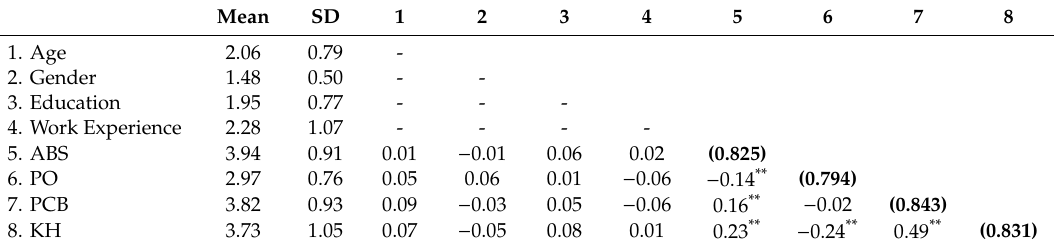
Table 3 indicates the correlations among the study variables. All correlation coe ffi cients of the study variable were in the proposed